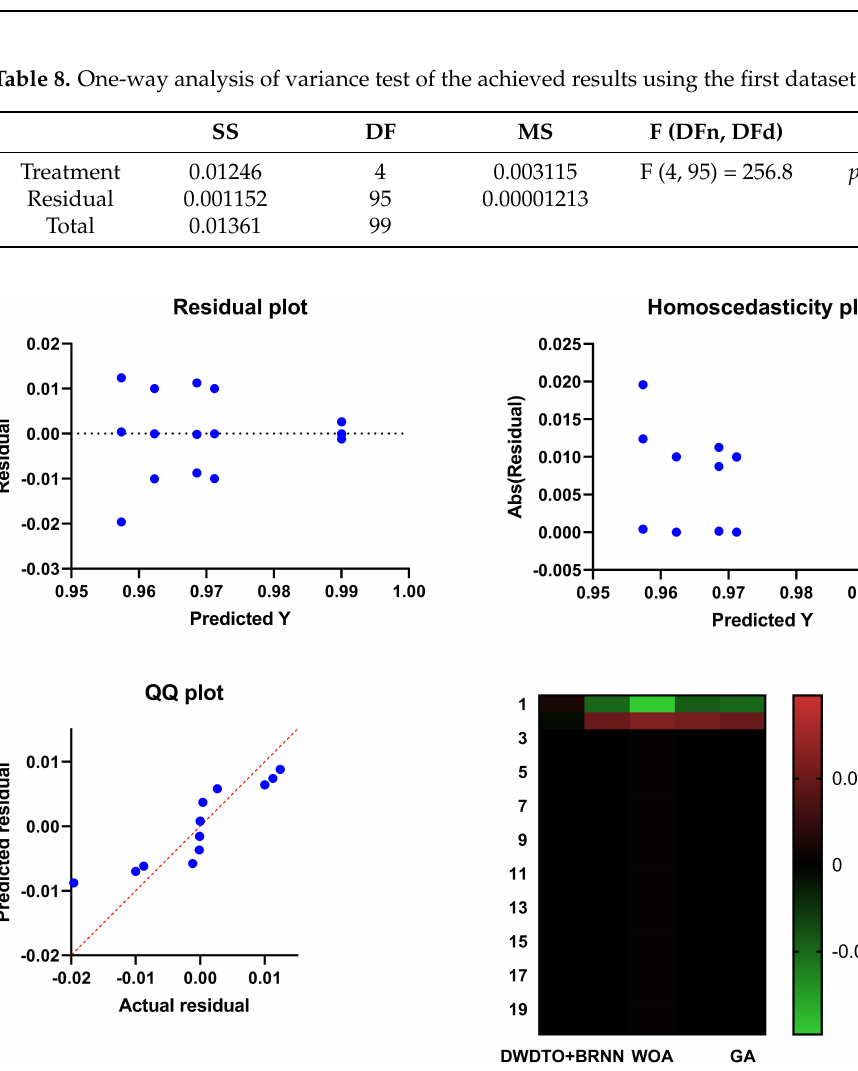
Figure 7. Visual representation of the results achieved by the proposed optimization algorithm in terms of the first dataset